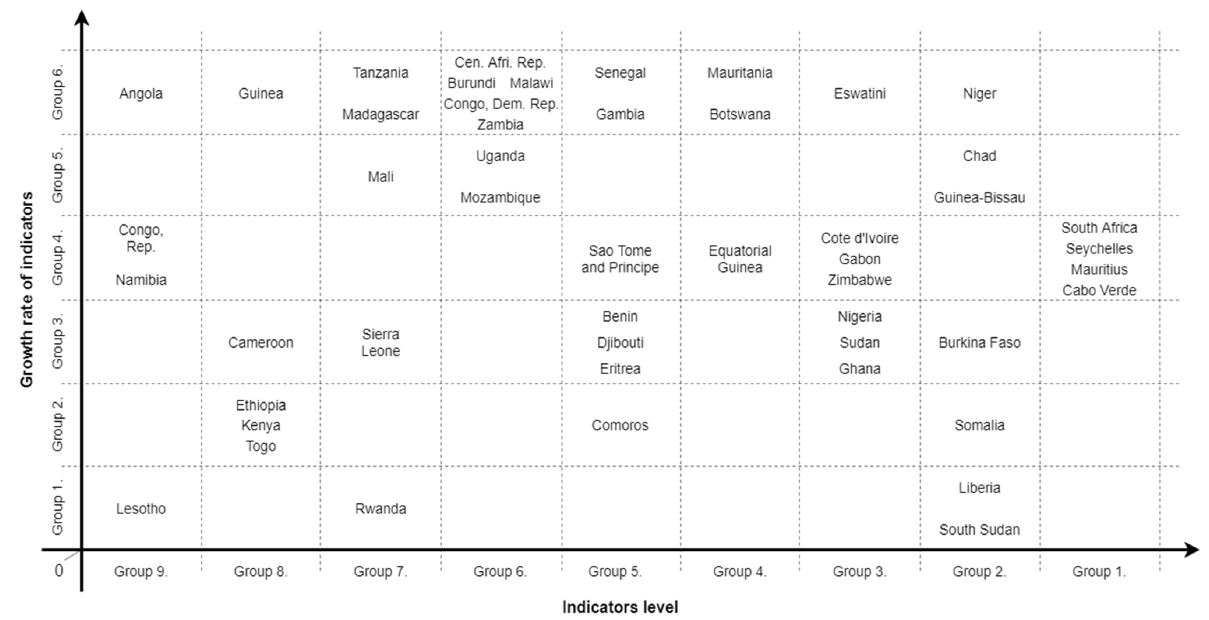
Figure 9. Development of the energy sector in individual countries of Sub-Saharan Africa based on indicators describing Sustainable Development Goal 7. Source : own study